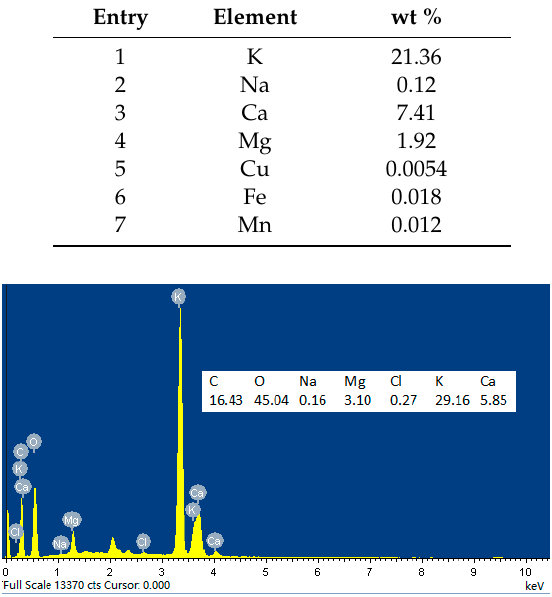
Figure 3. EDX spectrum of the pomelo peel ash. Molecules 2019 , 24 , x FOR PEER REVIEW